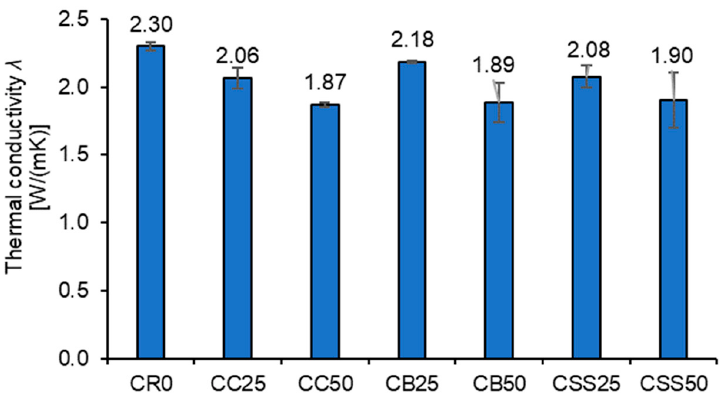
Figure 13. The average values of thermal conductivity coefficients of the tested composites.